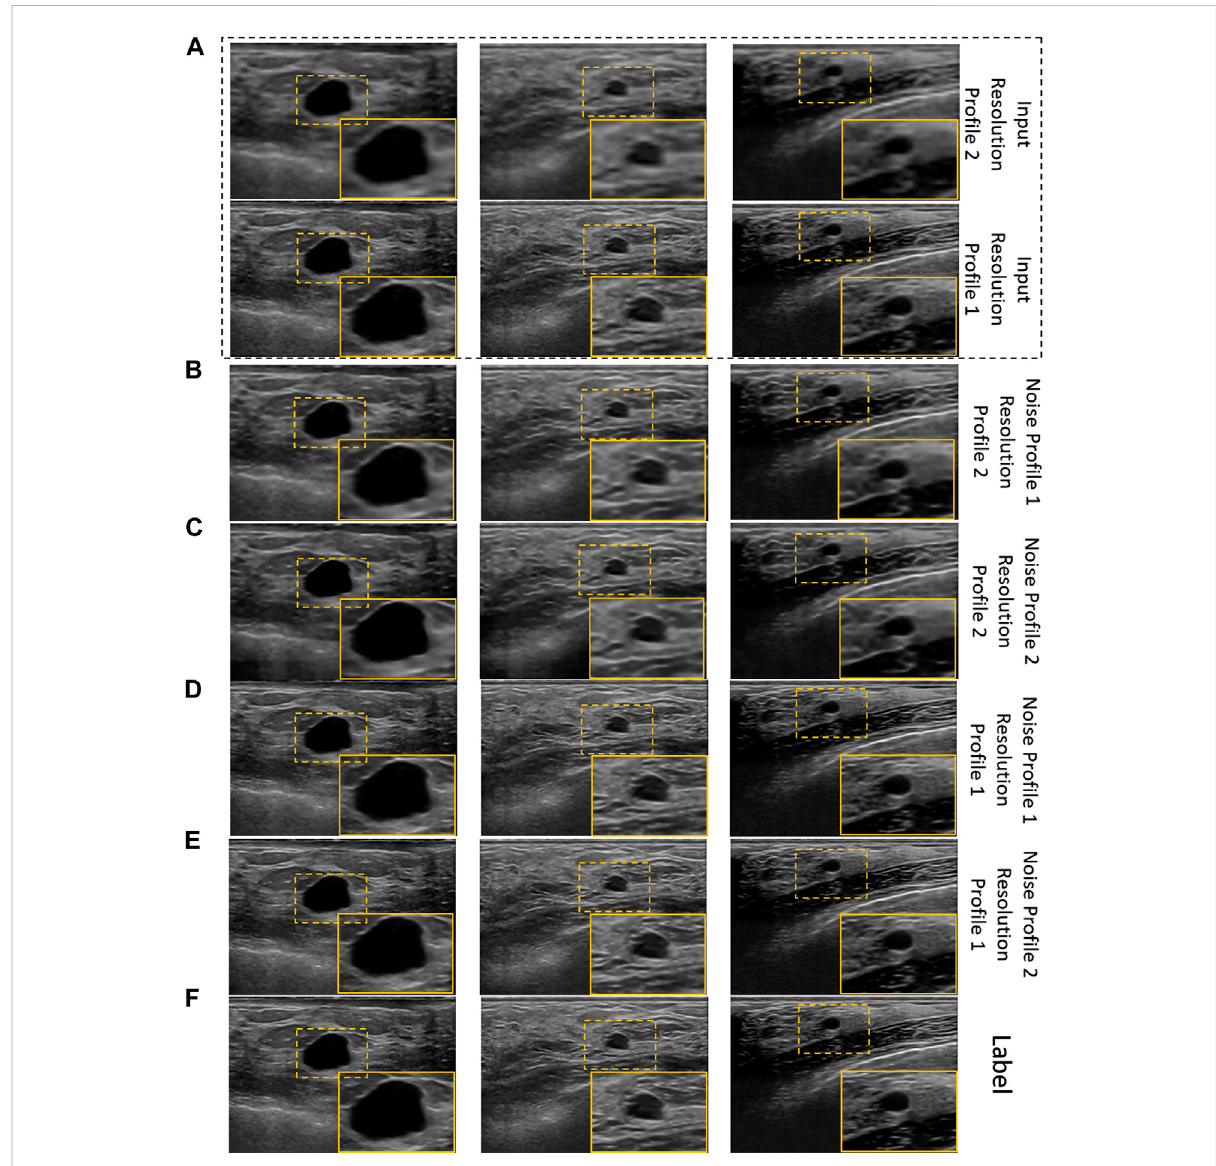
FIGURE 7 Visual results of theproposed USimage enhancementmodel for training andtestingof theproposed network with US imagedata as well as US imageformationphysicsinformedaugmentationdataset(trainingscheme2). (A) Inputimage (B) trainingandtestingonnoisepro fi leI(Rayleighnoise variance = 0.2, Gaussian fi lter standard deviation = 0.8) with resolution pro fi le II (64 × 64 to 256 × 256) (C) training and testing on noise pro fi le II (Rayleighnoisevariance=0.1,Gaussian fi lterstandarddeviation=0.7)withresolutionpro fi leII(64×64to256×256) (D) trainingandtestingon noisepro fi leI(Rayleighnoisevariance=0.2,Gaussian fi lterstandarddeviation=0.8)withresolutionpro fi leI(128×128 to256×256) (E) training and testing on noise pro fi le II (Rayleigh noise variance = 0.1, Gaussian fi lter standard deviation = 0.7) with resolution pro fi le I (128 × 128 to 256 × 256)